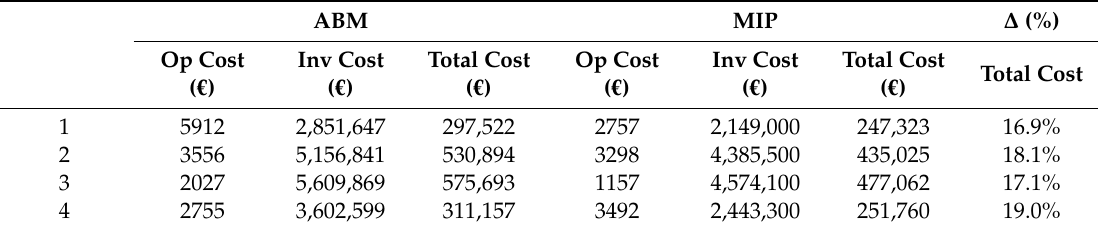
Table 3. Comparison of operating (Op) costs, investment (Inv) costs, and total costs between ABM approach in Net Logo, and transmission expansion planning (TEP) optimization approach in GAMS. ABM